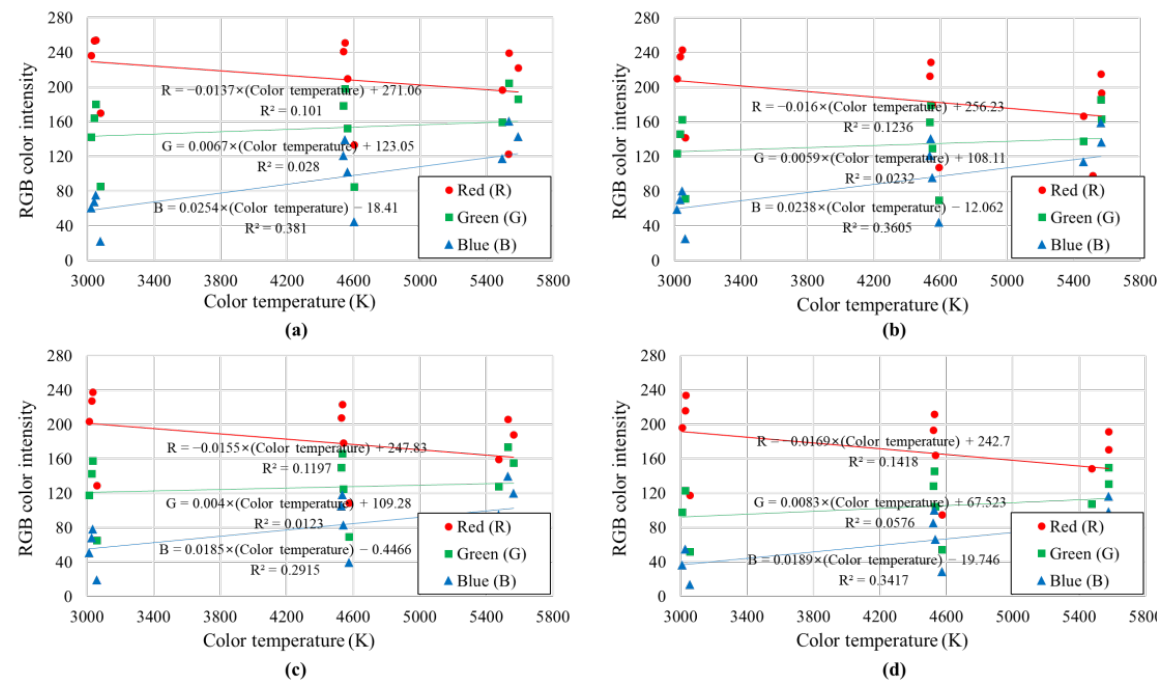
Figure 9. Mode RGB color intensities according to the color temperature of light: ( a ) Jumunjin sand, ( b ) Anseong soil, ( c ) Yongin soil, and ( d ) Gwanak soil.